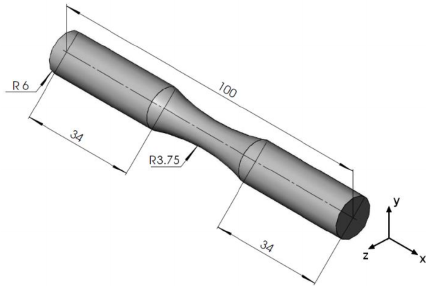
Figure 1. Specimen geometry and respective dimensions in